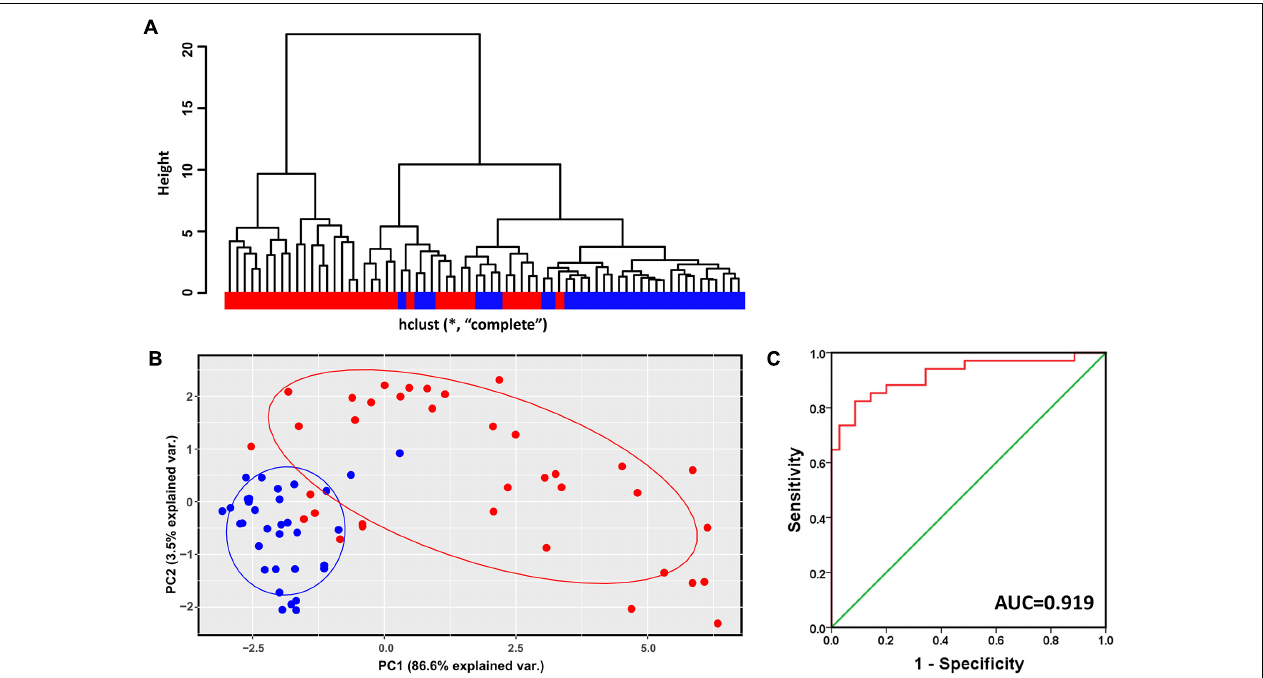
FIGURE 4 | Verification of the identified modules for discriminating cirrhosis from HCC. (A) Hierarchical clustering dendrogram of all the subjects in GSE56140 (distance metric: modular gene expressions, linkage method: complete). Red represents HCC subjects and blue represents cirrhosis subjects. (B) PCA plot of all the subjects in GSE56140. HCC subjects are labeled in red and cirrhosis subjects are labeled in blue. The ellipse shows 95% confidence intervals. (C) The first two PCs were subjected to binary logistic regression analysis to calculate the predicted probability which was applied to the ROC analysis. AUC, area under